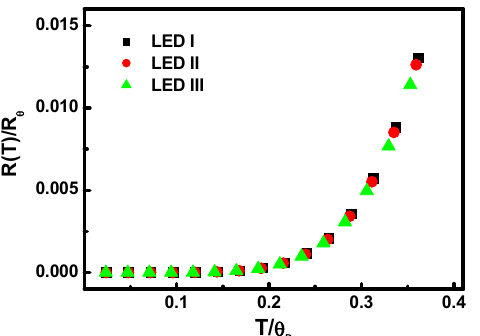
Figure 5. The corresponding universal curves of the Debye temperatures obtained by the so-called Gruneisen–Bloch relation from the ratio of the thermal resistance at the measurement temperature for different ratios of the cross-section for devices LED I, LED II, and LED III.